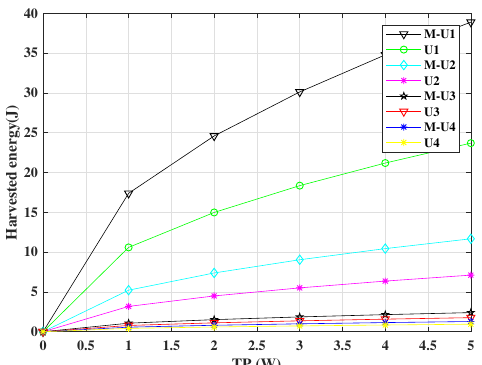
Figure 6. Harvested energy vs. transmit power for BEEM-NOMA (M-U1, M-U2, M-U3, and M-U4) and NOMA (U1, U2, U3, and